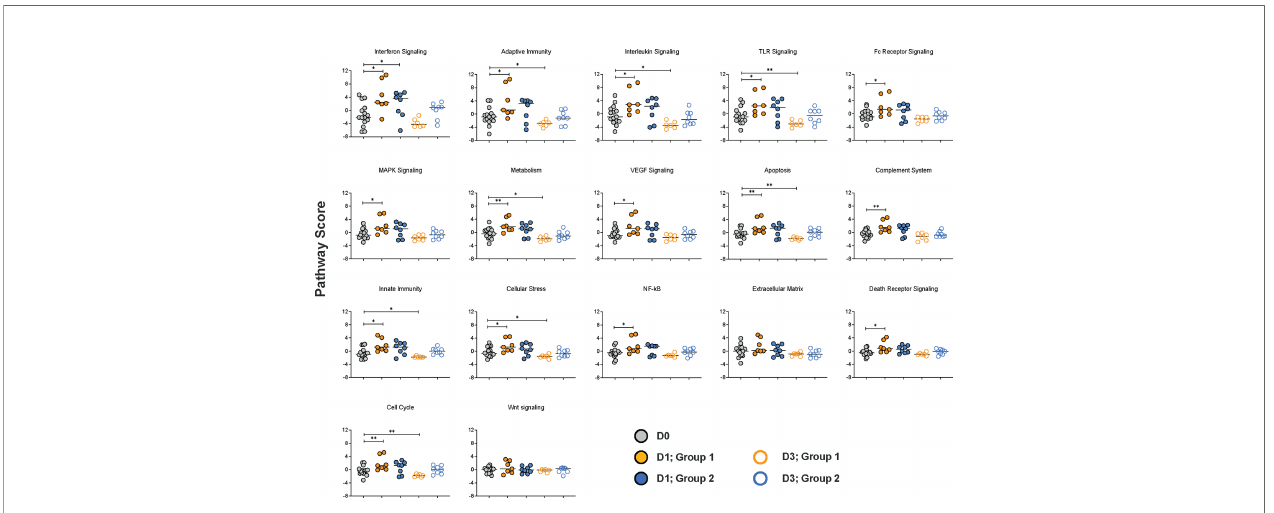
FIGURE 6 | Immune pathways affected by the vaccine prime. Based on the fi rst principal component of the normalized relative gene expression and the number of genes belonging to a speci fi c immune pathway, a pathway score standardized by Z scaling was generated by the nSolver ™ software. Each pathway is represented by a speci fi c graph displaying the pathway scores on D0 (grey circles), and on days 1 ( fi lled circles) and day 3 (open circles) post vaccination for Group 1 (orange circles) and Group 2 (blue circles) animals. Differences in pathway scores were determined by Mann-Whitney test with * and ** representing p < 0.05 or p < 0.01,